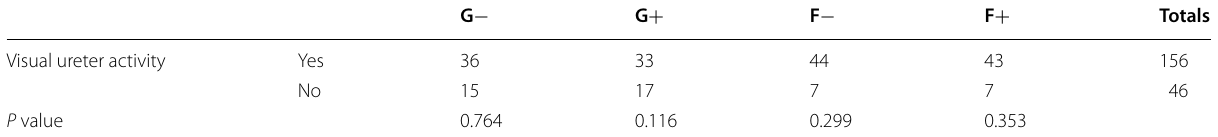
Table 5 A. Observed frequencies (n) and overall differences (Fisher’s exact test) in incidence of visually discernable activity in in the ureters between the cohorts. Results from post hoc pairwise Z‑tests corrected for multiple testing are shown as p ‑values per cohort. B. Logistic regression analysis assessing the relation between administration of furosemide or choice of tracer on the incidence of visually discernable activity in the